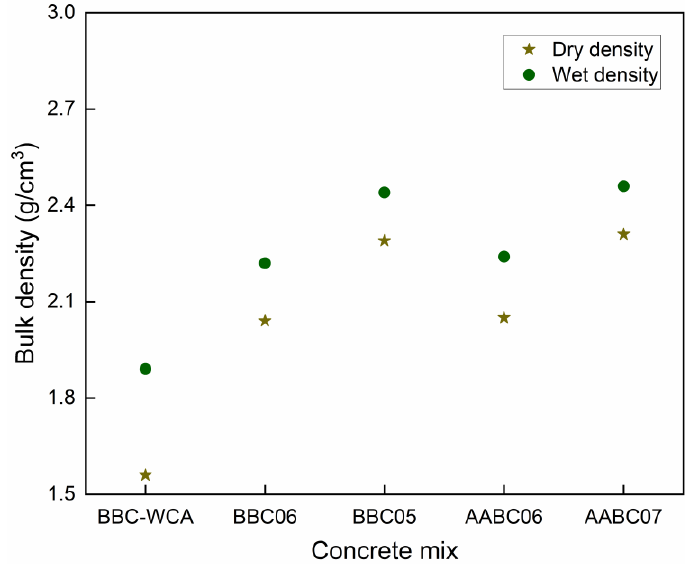
Materials 2020 , 13 , x FOR PEER REVIEW Figure 12. Dry density and saturated density for each concrete mix. Figure 12. Dry density and saturated density for each concrete mix.